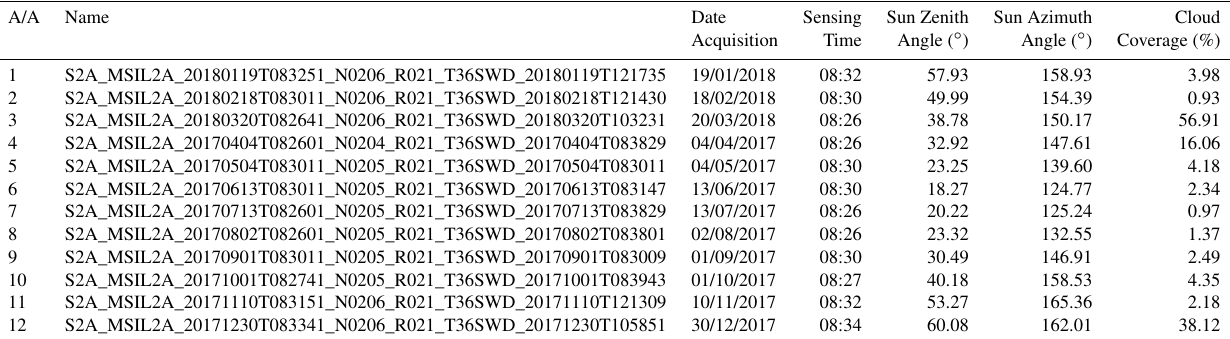
Table 1. Details for the processed Sentinel-2